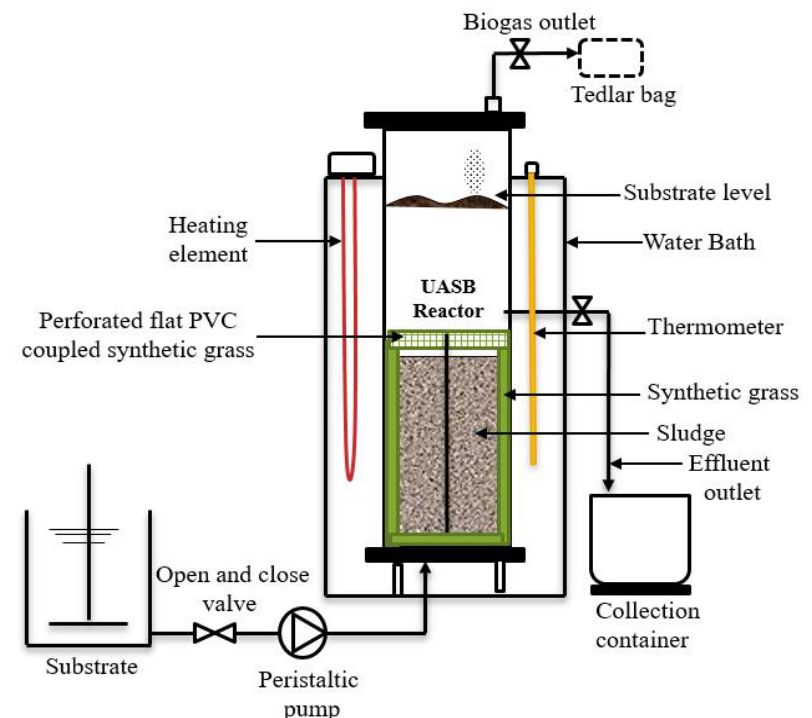
Figure 1. Schematic representation of the modified hybrid upflow anaerobic sludge blanket (HUASB) reactor.